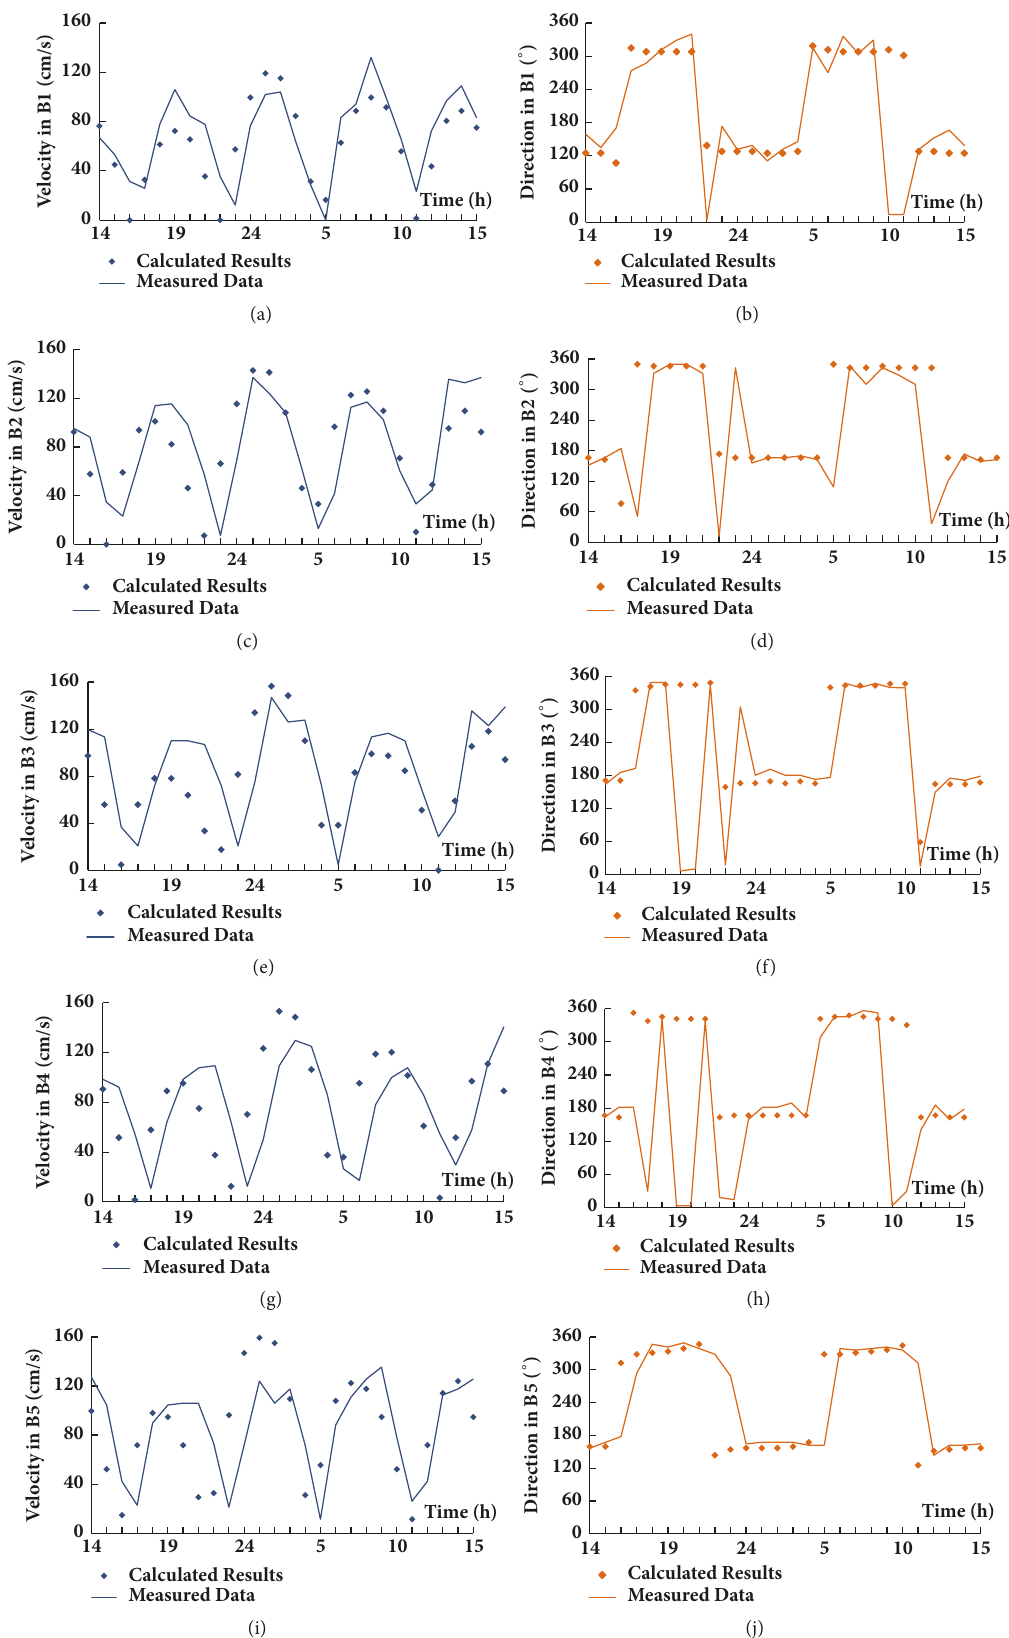
Figure 10: Validation of flow velocity and direction: (a), (c), (e), (g) and (i) are validation results of flow velocity; (b), (d), (f), (h) and (j) are validation results of flow